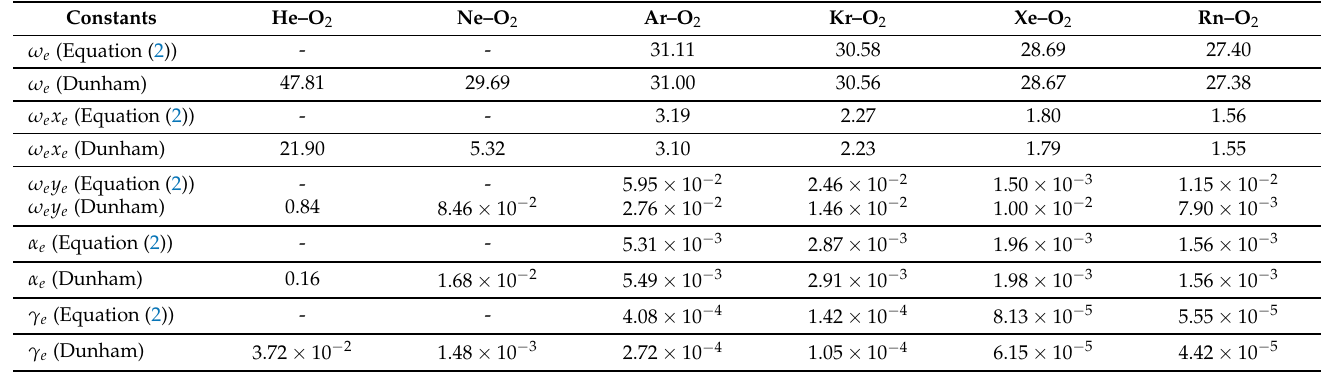
Table 4. Ng–O 2 spectroscopic constants (cm − 1 ) obtained through the CCSD(T)/aug-cc-pVTZ poten- tial energy curve.